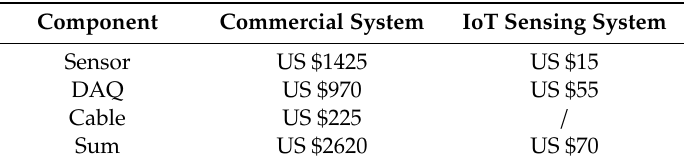
Table 4. System cost